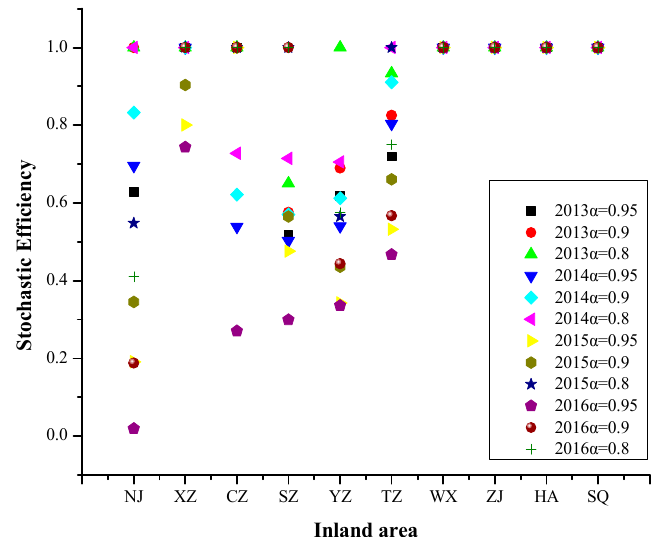
Figure 10. Stochastic Efficiency Values in Inland Area at Different Risk Levels in 2013–2016.